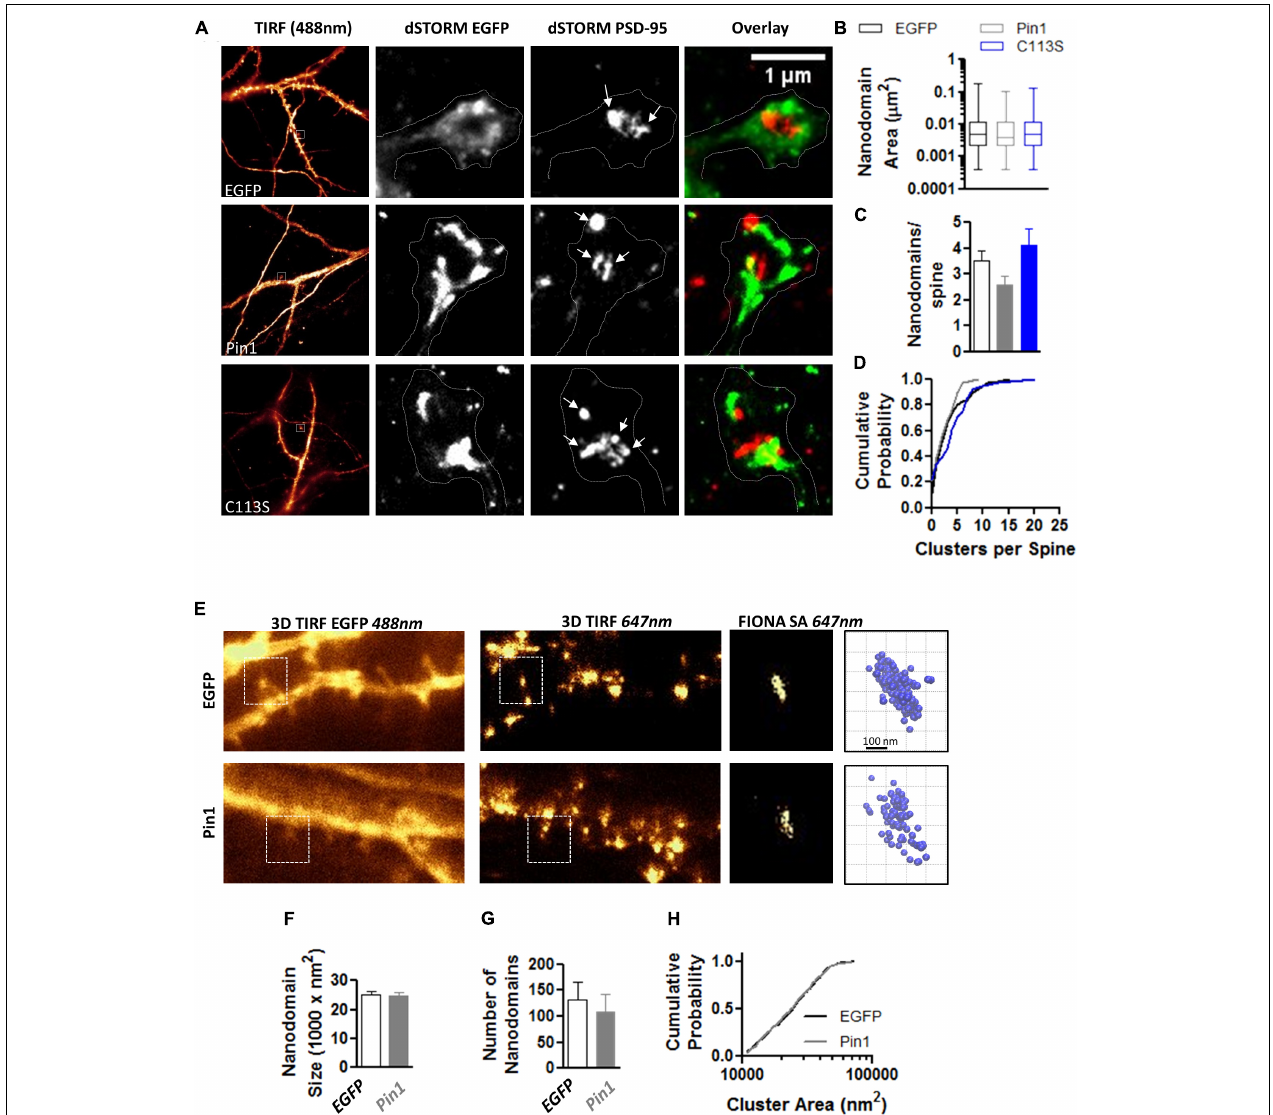
FIGURE 3 | Pin1 does not regulate PSD-95 and AMPAR nanodomains. (A) Images of hippocampal cultured neurons at 16 DIV imaged under widefield TIRF illumination and the superresolution reconstruction of the 568 nm (for EGFP) and 647 nm (for PSD-95) channel. Overlay of dSTROM images for EGFP and PSD-95 shown on right. (B) Box plot graph showing similar sized nanodomains for neurons expressing EGFP, Pin1 or the C113S mutant. EGFP 0.013 ± 0.001, Pin1 0.012 ± 0.002, and C113S 0.011 ± 0.001 µ m 2 , Kruskal–Wallis test with Dunn’s multiple comparison test, p = 0.35. (C) The average number of nanodomains per dendritic spine for neurons expressing EGFP, Pin1 or the C113S mutant. EGFP 3.52 ± 0.39, Pin1 2.58 ± 0.36, and C113S 4.12 ± 0.64, Kruskal–Wallis test with Dunn’s multiple comparison test, p = 0.31. (D) Cumulative probability plot of data shown on C showing a slight shift toward spines with a higher number of nanodomains for cells expressing the C113S. Unpaired t -test Pin1 vs. C113S, p = 0.02. (E) Live cell widefield TIRF images for EGFP channel and Streptavidin 647 nm stained GluA2 receptors (FIONA) for hippocampal cultured neurons transfected with EGFP or Pin1. Boxed regions show a high-resolution image for the GluA2 staining and 3D VMD plots of AMPAR nanodomains. (F) Pin1 overexpression does not alter the size of nanodomains. EGFP 25094 ± 1112, n = 8 cells, and Pin1 24993 ± 1025 nm 2 , n = 6 cells. Unpaired t -test p = 0.95. (G) Pin1 overexpression does not alter the number of nanodomains along dendritic fields. For EGFP cells 132.3 ± 34.09 nanodomains, n = 8 cells, and Pin1 109.2 ± 33.33, n = 6 cells. Unpaired t -test, p = 0.95. (H) Cumulative probability plot of data shown on G for EGFP and Pin1 expressing